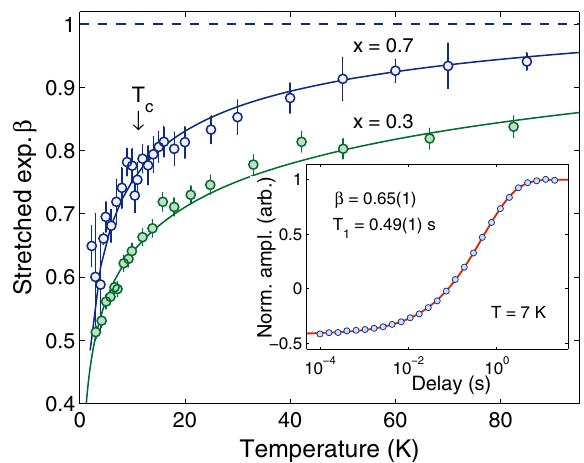
Fig. 5 The simultaneous presence of As and P atoms implies a strongly stretched NMR relaxation. The stretched-exponential coef fi cient β shows a monotonic decrease as the temperature is lowered, starting well above T c , yet distinct for samples with x values above and below x = 0.5. Inset: the recovery of magnetization in a typical 31 P NMR spin-lattice relaxation experiment below T c